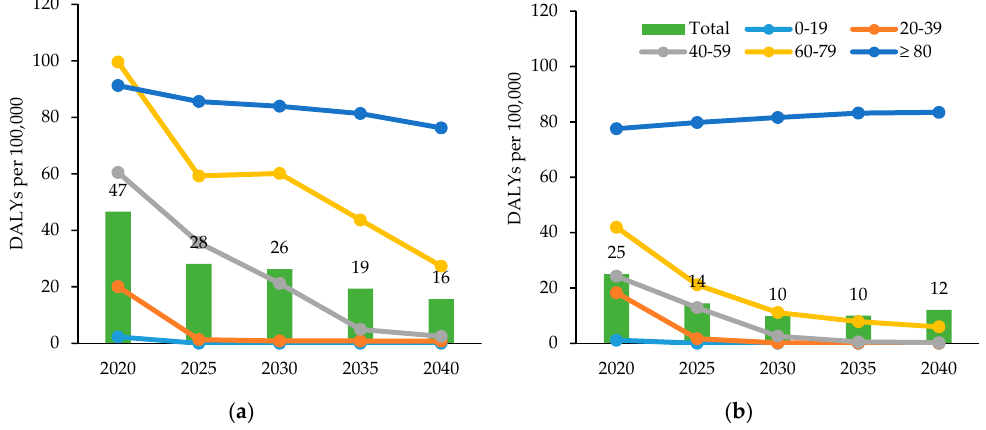
Figure 5. Projected disability-adjusted life years due to tuberculosis in Korea by sex and age group, 2020–2040. ( a ) The projected disability-adjusted life years due to tuberculosis in males, by age group. ( b ) The projected disability-adjusted life years due to tuberculosis in females, by age group.